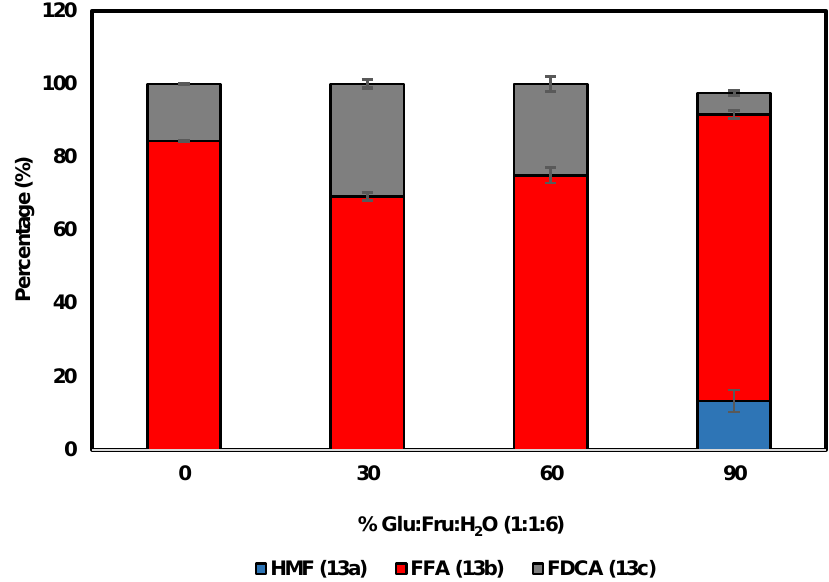
Figure 2. Effect of Glu:Fru:H 2 O (1:1:6) concentration on the HMF ( 13a ) oxidation catalyzed by HMFO.